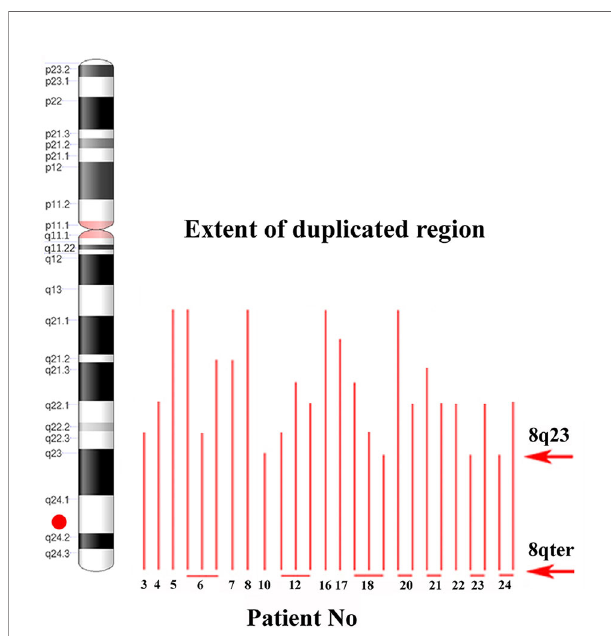
FIGURE 3 | The identi fi cation of the smallest duplicated region using the M- BAND method. An ideogram of chromosome 8 on the left side. A red dot indicates the position of the MYC gene. Red lines show the size of the duplicated 8q region individual patients (patient numbers under red lines; several lines in one patient indicate more than one clone with MYC gain). Red arrows delimit the smallest duplicated